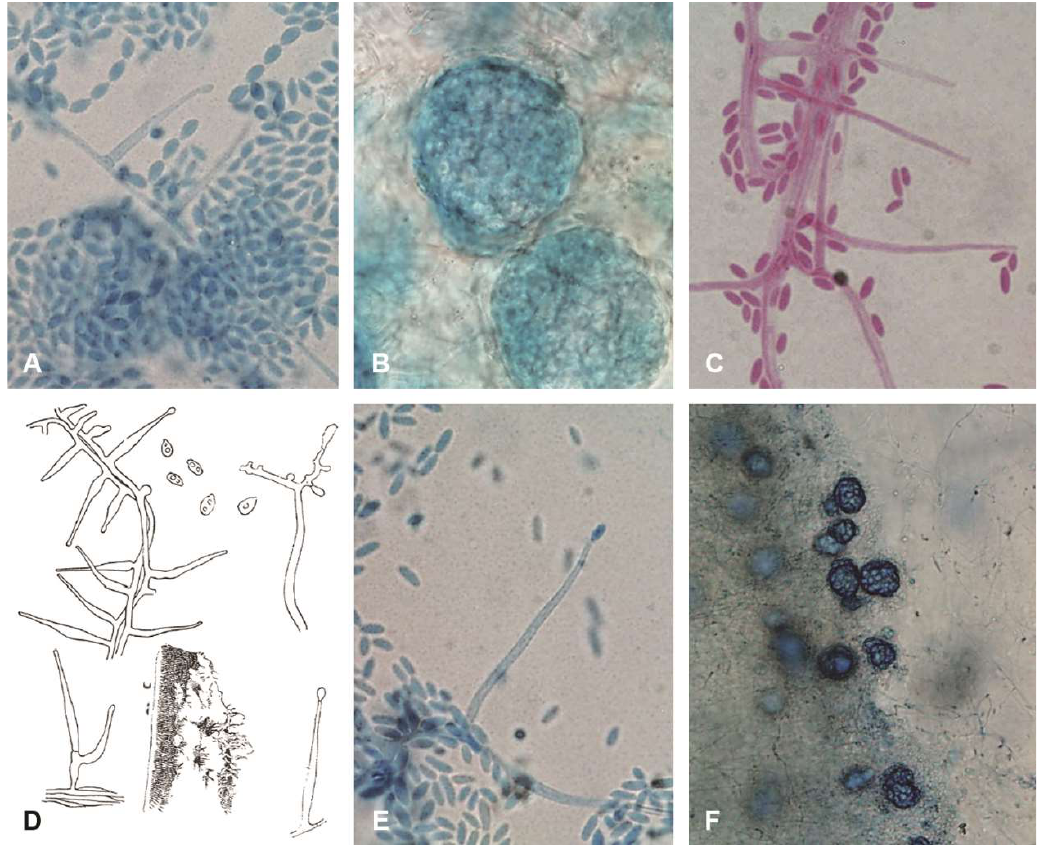
Figure 1. Morphological diversity of Acremonium sclerotigenum/egyptiacum plus a comparison with an illustration of the original Acremonium potronii . ( A – E ) ×1000, ( F ) ×400. Blue structures stained in lactic-acid-cotton-blue stain, reddish in lactofuchsin: ( A ) CBS 545.89, catenate-conidial isolate originally identified as A. alternatum ; ( B ) CBS 545.89 sclerotia; ( C ) CBS 251.95 mucoid-conidial isolate with ellipsoidal conidia, originally identified as A. potronii ; ( D ) original Vuillemin drawing of A. potronii ; ( E ) CBS 113276, typical mucoid-conidial A. sclerotigenum isolate with cylindrical conidia; and ( F ) heavily sclerotial Iranian isolate Zare 60-#3. Table 2. Isolates in the Acremonium sclerotigenum / egyptiacum complex typed by ITS barcode type. Isolate # (CBS Unless Otherwise Indicated) and